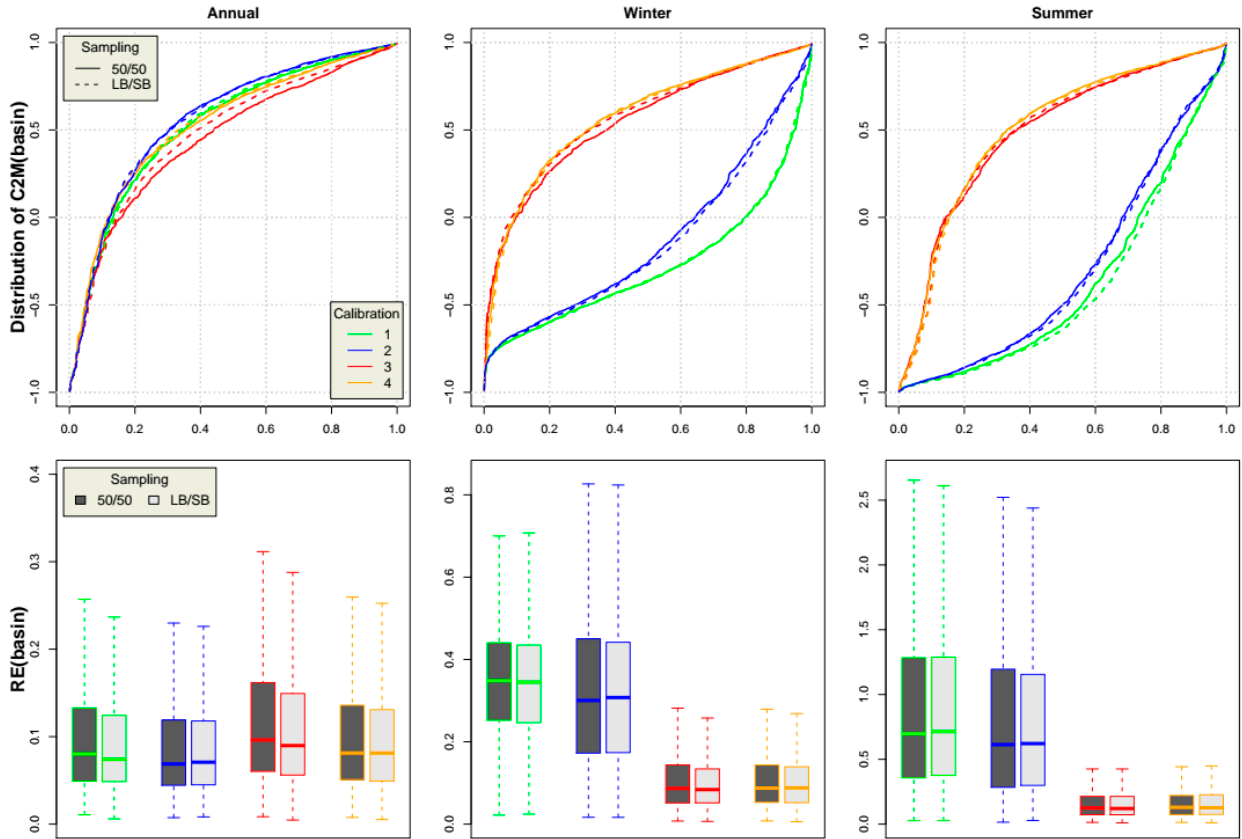
Figure 4. 𝐶 (cid:2870)(cid:3014) and RE criteria calculated on observation in calibration catchments. Figure 4. C 2 M and RE criteria calculated on observation in calibration